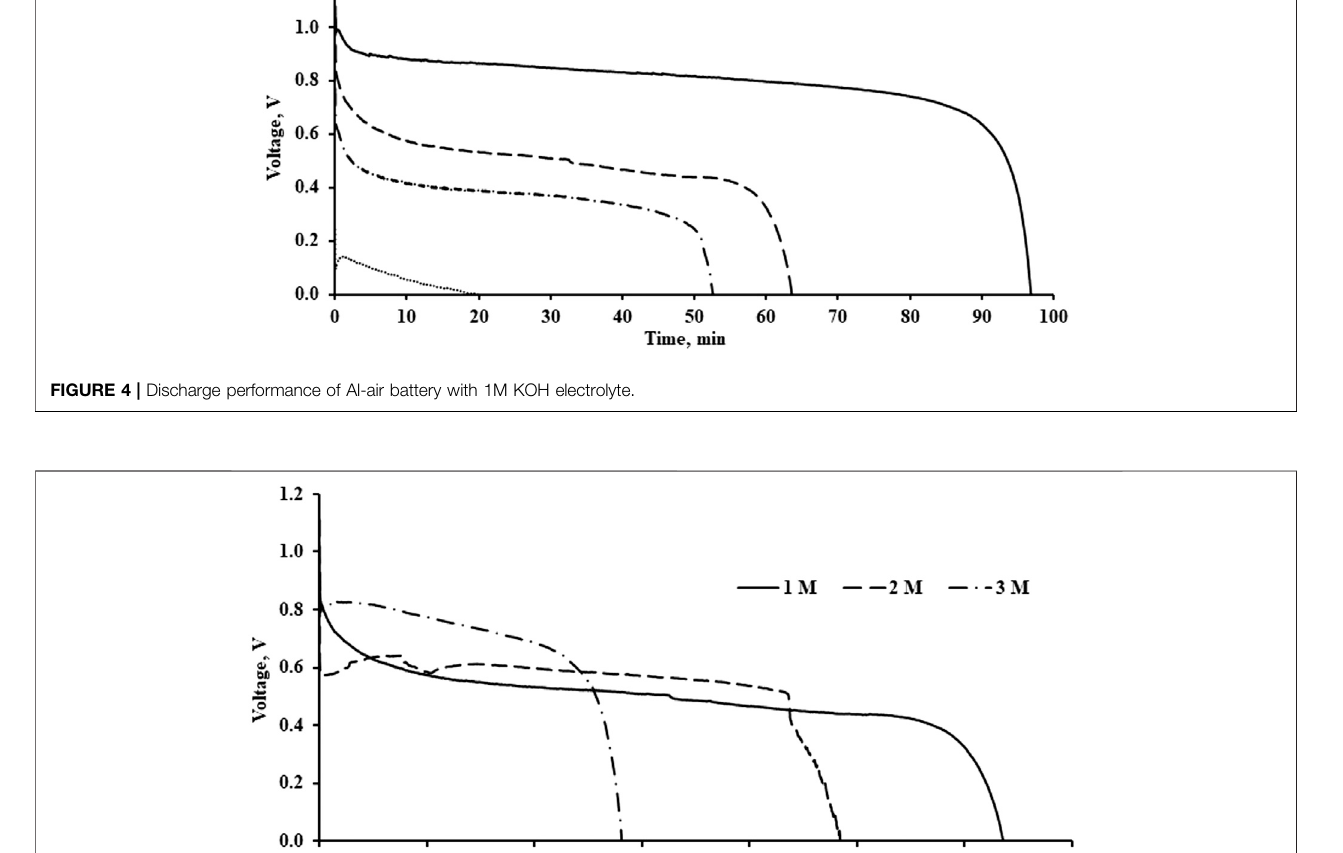
Frontiers in Energy Research |